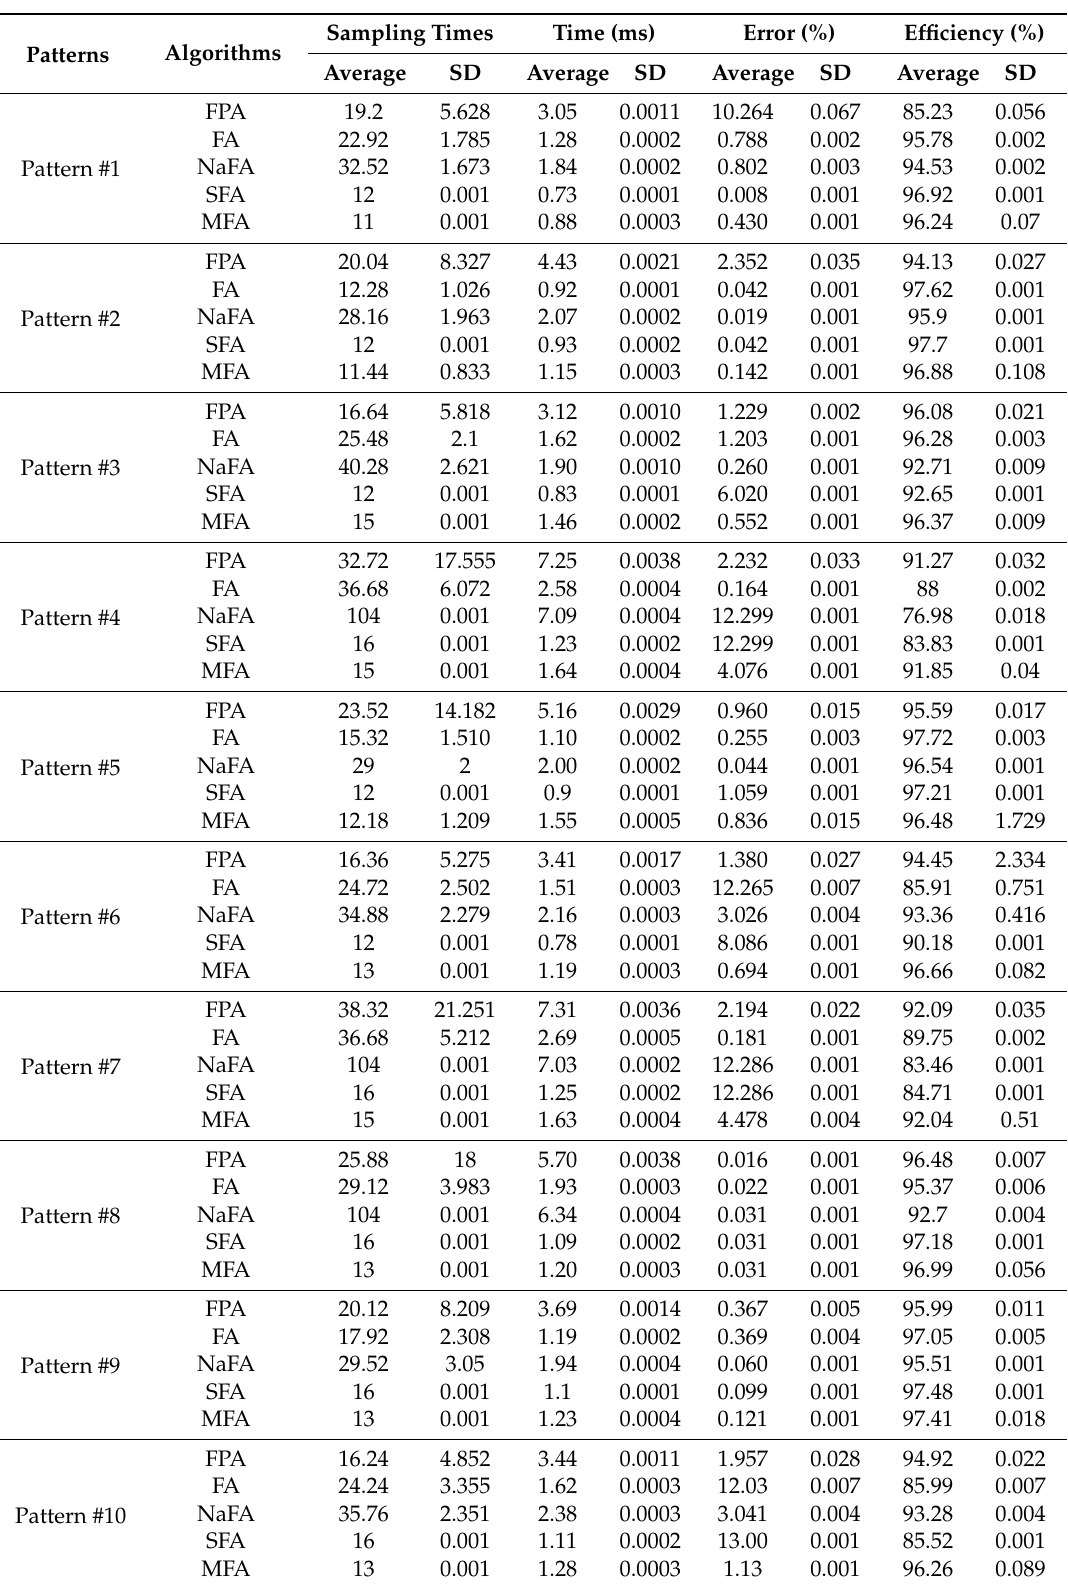
Table 9. Simulation results of the tracking speed, accuracy and